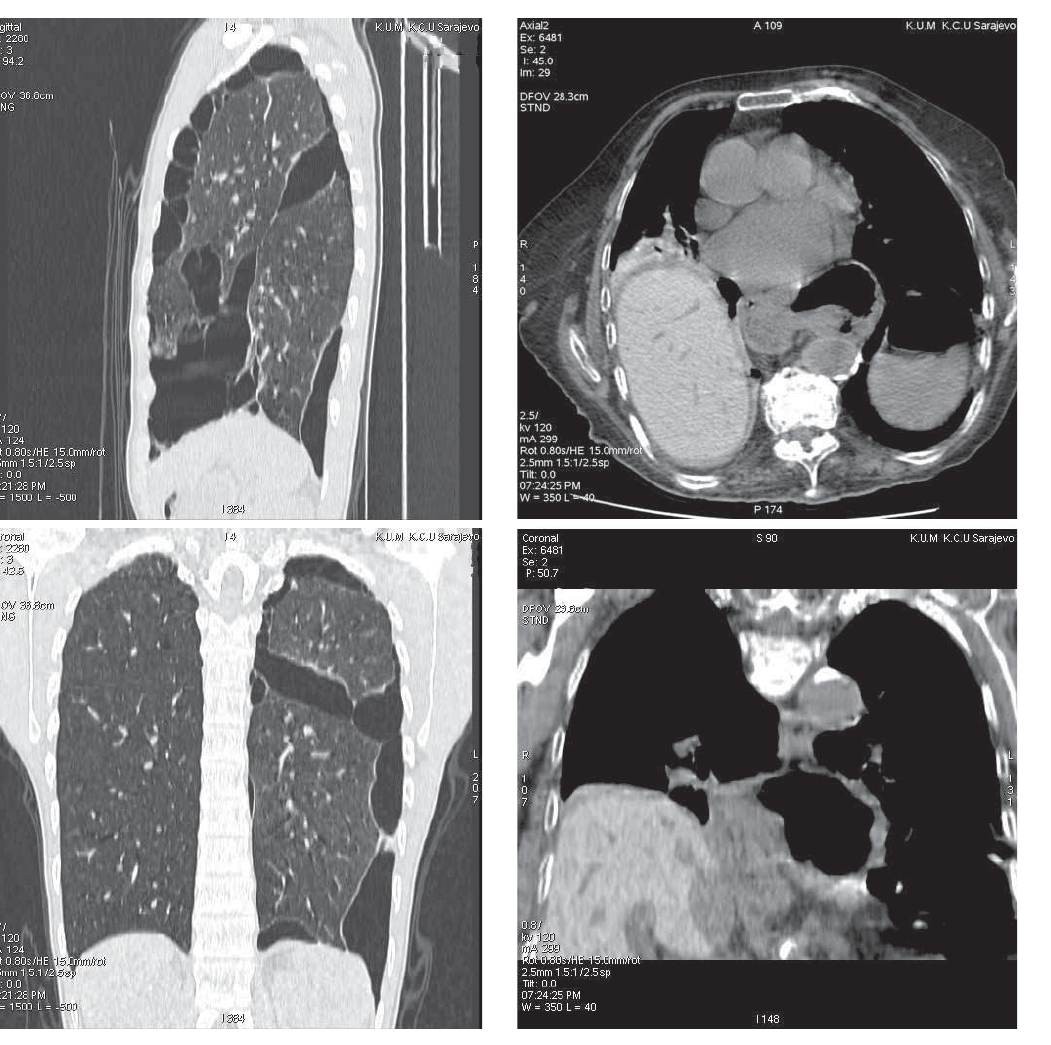
FIGURE 7. Spontaneous pneumothorax with large bullae FIGURE 8. Hiatus hernia as the cause of acute non-cardiac chest